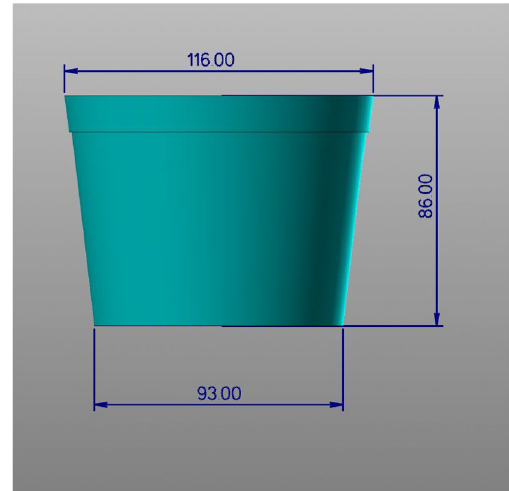
Fig. 19 Dimensions of the